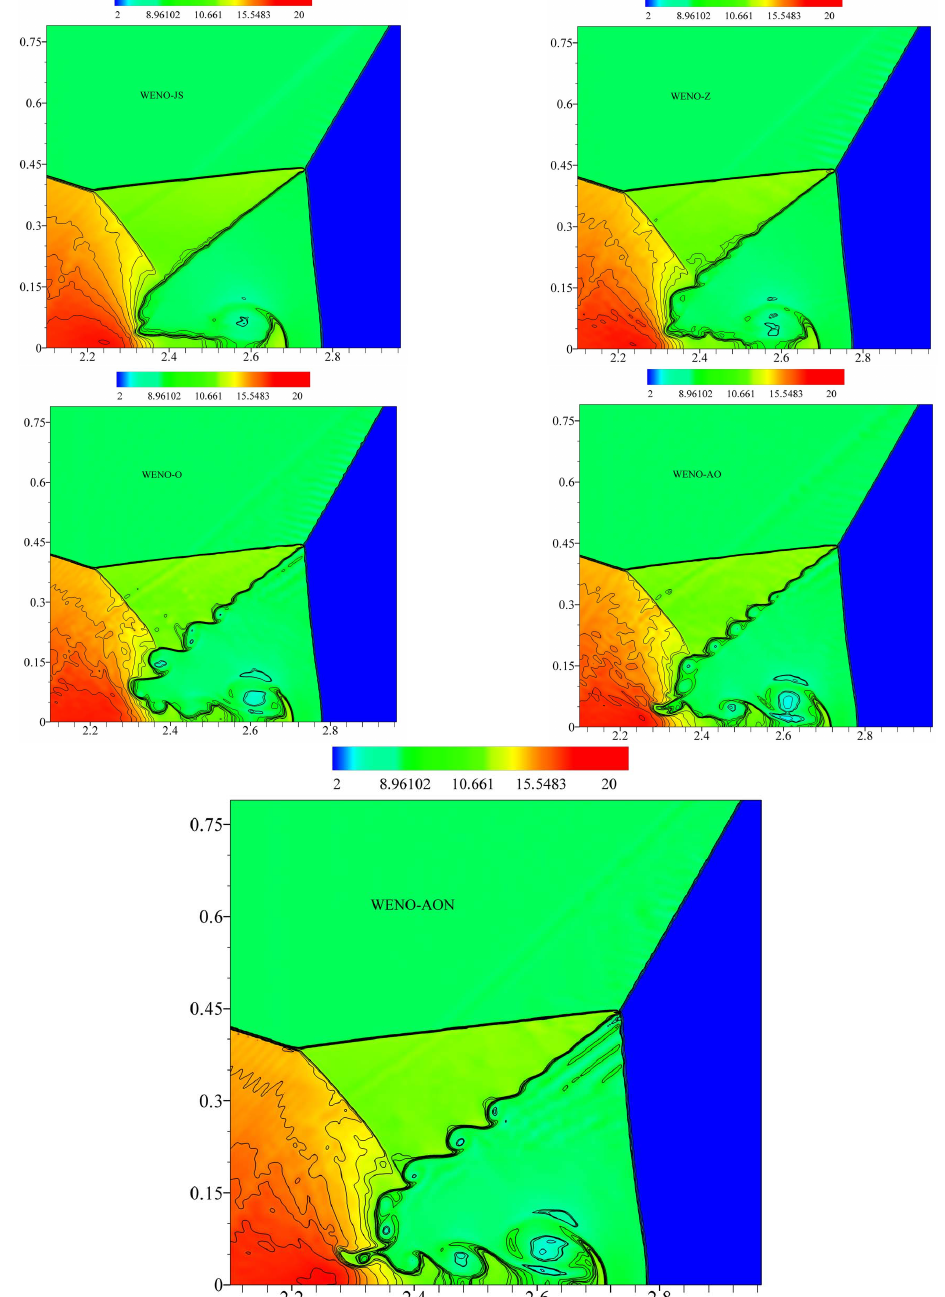
Figure 20. Close view of equally spaced contours of two-dimensional double-Mach reflection of strong shock of Example 7 (Section 6.3.1) at time of 0.2, CFL = 0.475, [ 0,4 ] × [ 0,1 ] 2-D domain and 1600 × 400 mesh